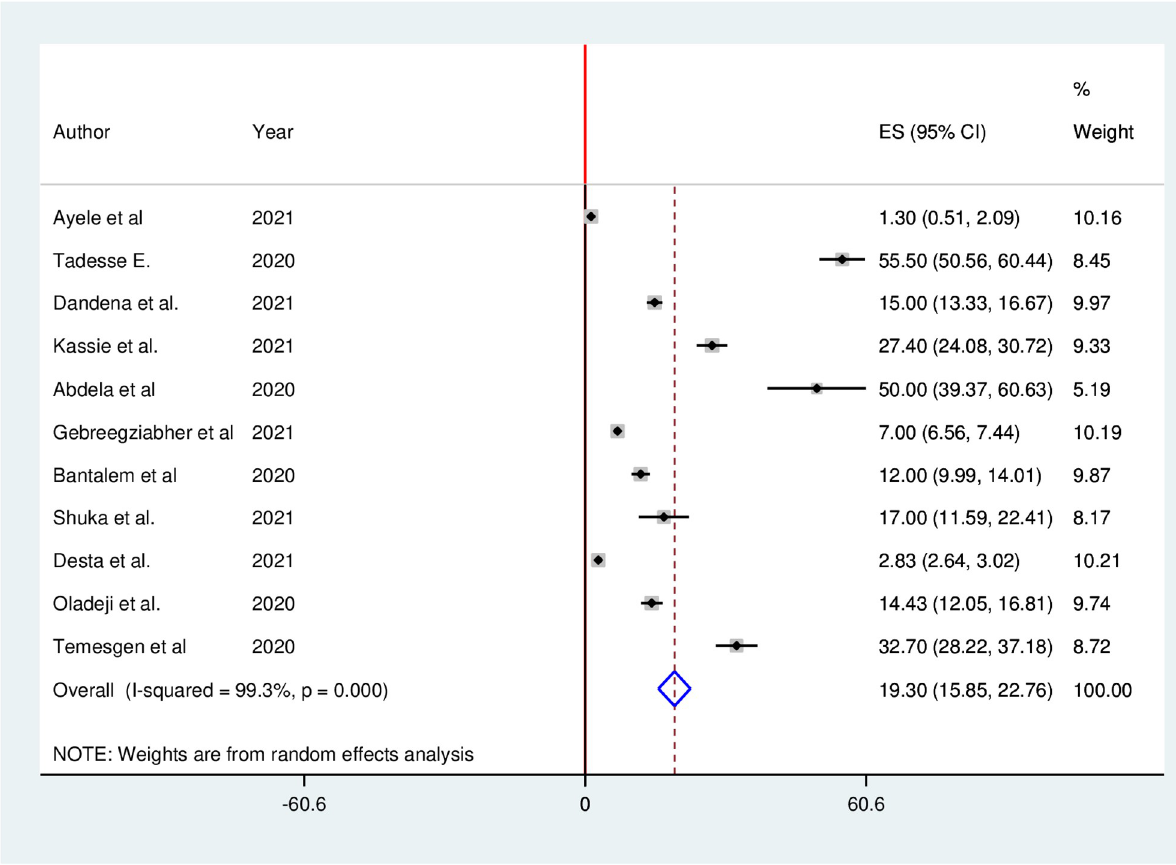
Fig 5. Forest plot of the pooled reduction of antenatal care services utilization during COVID-19 pandemic in Ethiopia, 2021.